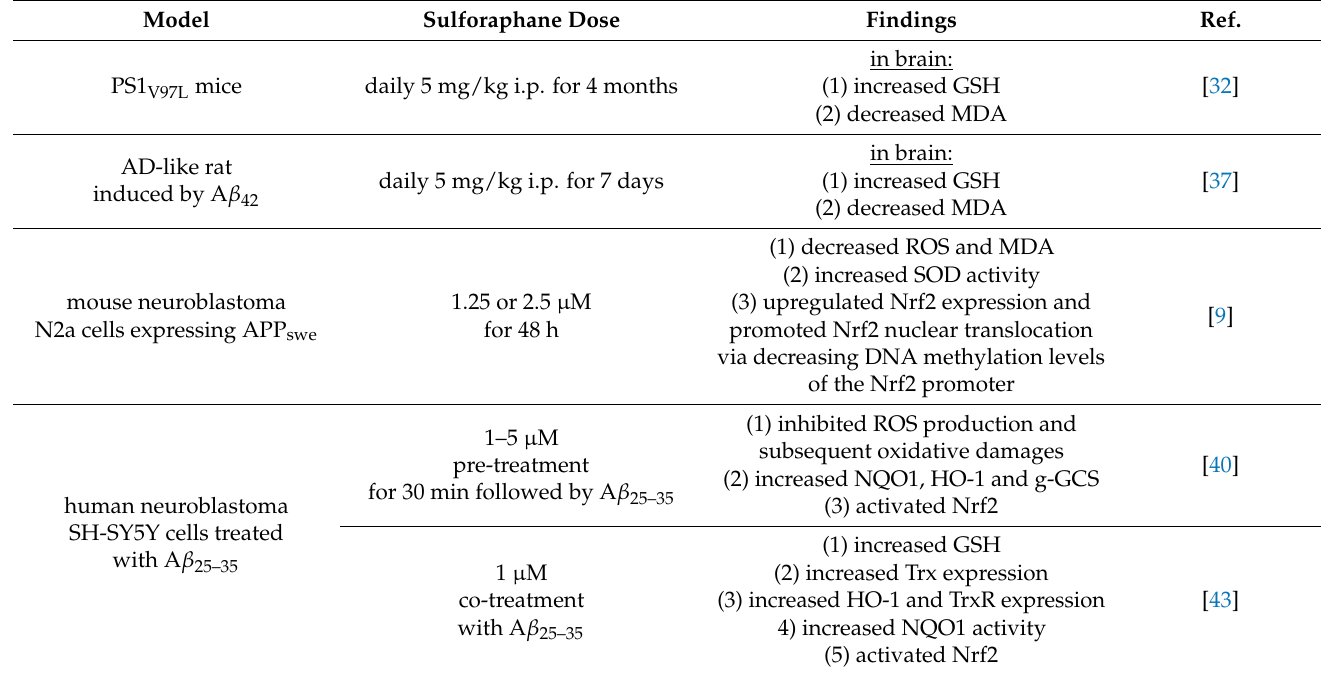
Table 4. The effects of sulforaphane on Alzheimer’s disease (AD)-associated oxidative stress biomarkers in AD-like models. Model Sulforaphane Dose Findings